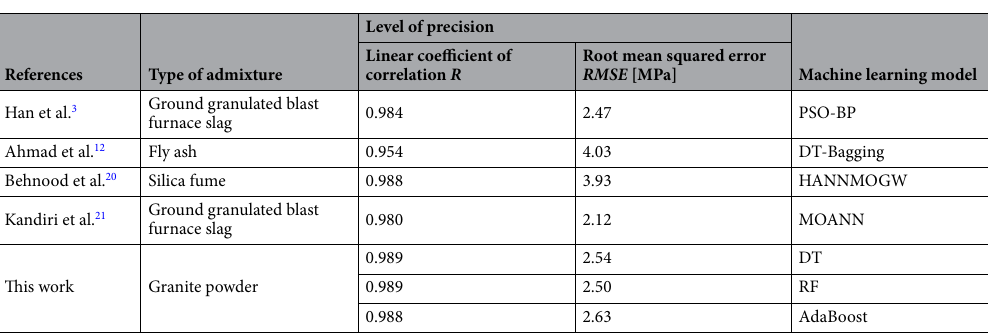
Table 4. Comparison of algorithms used for compressive strength prediction of green cementitious composites containing different